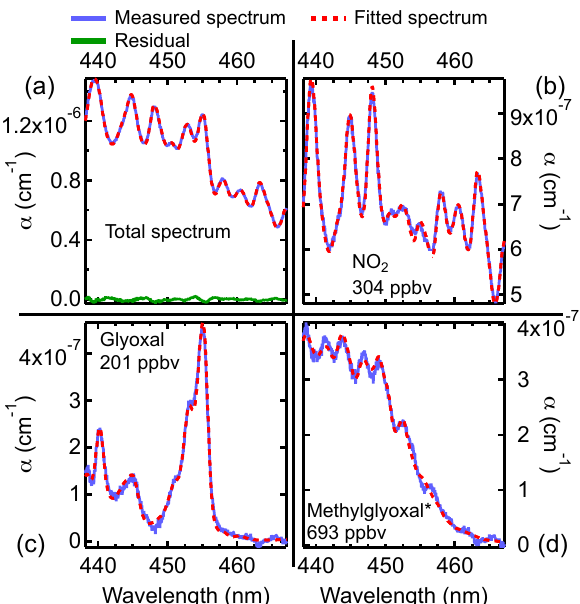
Figure 8. Fit results from the peak of emissions from Fire 060 (rice straw). (a) The measured spectrum (blue), the fitted spectrum (red), and the residual (green). Fits for NO 2 (b) , glyoxal (c) , and methylglyoxal (d) . At these concentrations, the small features in the methylglyoxal cross section can be resolved. The methylglyoxal concentration given in the figure is the retrieved concentration, and has not been corrected for the interference from